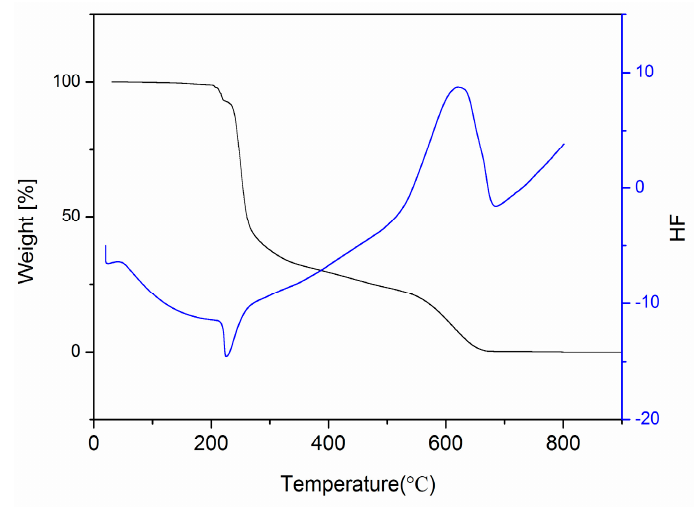
Figure 10. TG and DSC curves of HMD.